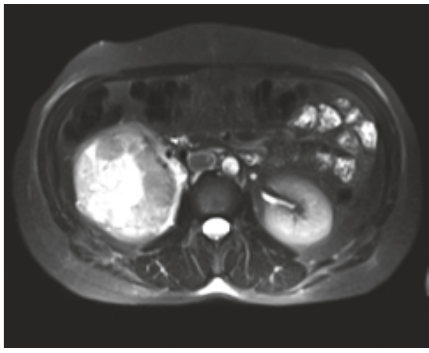
Figure 1: On contrasted CT, 80 mm × 76 mm renal mass with heterogeneous contrast enhancement arising from the lower pole of the right